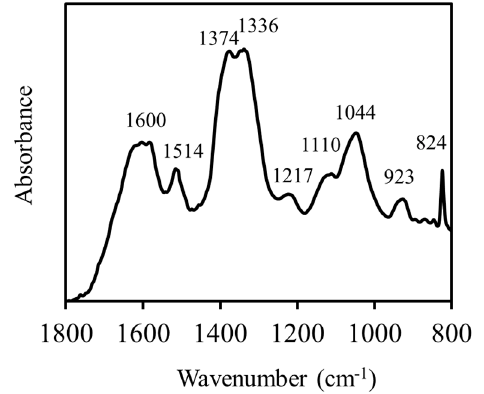
Figure 1. ATR-FTIR spectra of pristine EPS at pH 6.0. Table 2. Band assignment in the FTIR spectrum obtained from the pristine EPS based on the previous studies [30,35,36].